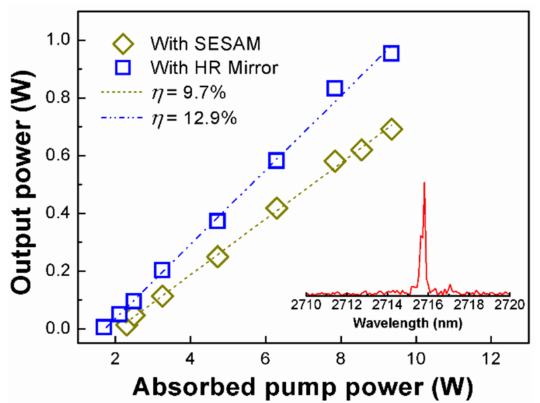
Figure 2. Output power as a function of the absorbed pump power of the Er:Lu 2 O 3 ceramic laser under CW and passively Q-switched mode of operation. Inset: laser output spectrum at 2716 nm.